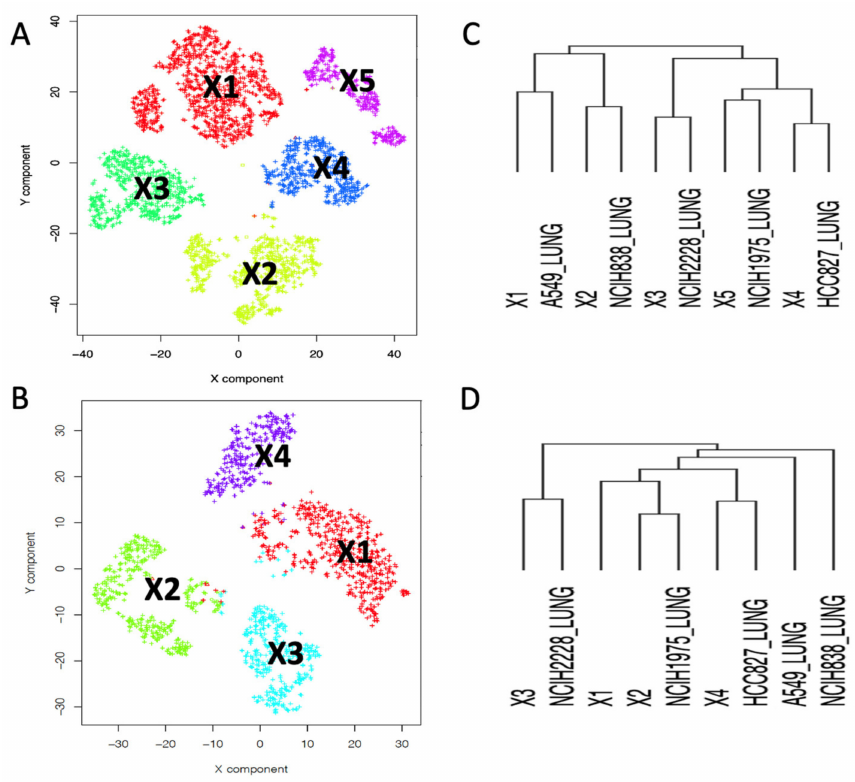
Figure 2. Assignment of cell line type to clusters generated with Seurat [18], implemented in rCASC [19]. ( A ) Five clusters were generated with Seurat (resolution = 0.1), using 2500 genes selected as the most variant within the 5000 most expressed in the RNA-5c experiment. ( B ) Four clusters were generated with Seurat (resolution = 0.1) using RNA-3c experiment, selecting the same 2500 genes used in ( A ). ( C ) RNA-5c hierarchical clustering (Euclidean distance, average linkage) of log 2 CPM clusters’ pseudo-bulk expression, row-mean centered, combined with the log 2 TPM, row-mean centered, for CCLE lung cell lines A449, NCIH838, NCIH2228, NCIH1975 and HCC827. ( D ) RNA-3c hierarchical clustering same parameters used in ( C ). In the RNA-5c experiment, hierarchical clustering of the clusters’ pseudo-bulks, combined with the expression data retrieved for the bulk RNAseq for the five cell lines ( C ) well correlate to each other. Only in the RNA-3c experiment, cluster X1 ( D ) shares similarity with more than one cell line (NCIH1975 and